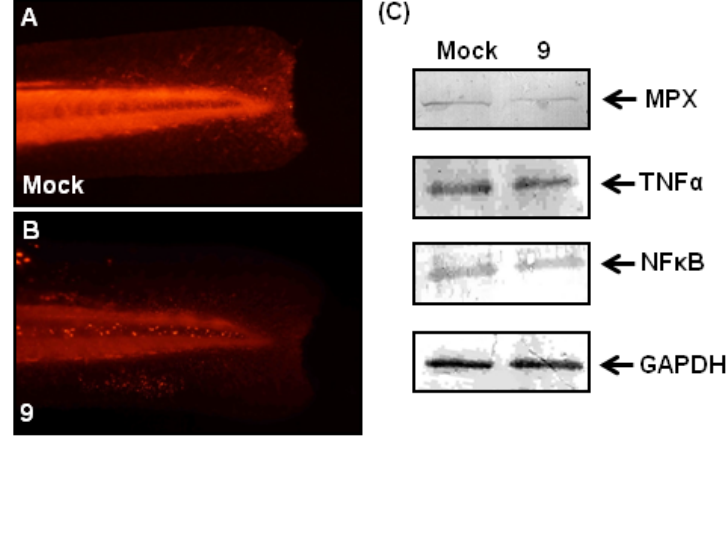
Figure 6. Effects of compound 9 on fin-amputated zebrafish larvae. Fin-amputated zebrafish embryos derived from the mock control ( A ) or the compound 9 -treated groups ( B ) were stained with antibody against Mpx. ( C ) Results of western blot analysis of the mock control and the compound 9 -treated embryonic lysates using antibodies against Mpx, NF κ B, TNF α and